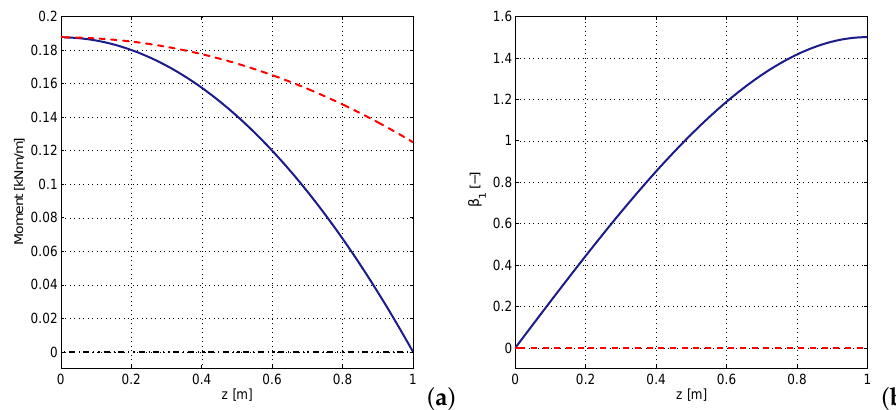
Figure 8. Simply supported circular plate subject to uniform pressure q w . ( a ) Bending moment M 11 - blue solid line, bending moment M 22 - red dotted line), twisting moment M 12 - black dashed-dot line; ( b ) Rotation β 1 - blue solid line, rotation β 2 - red dotted line. Simply supported circular plate in free vibration. Frequency